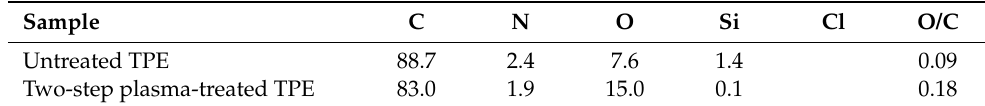
Table 5. XPS composition of plasma-treated catheters (in atomic